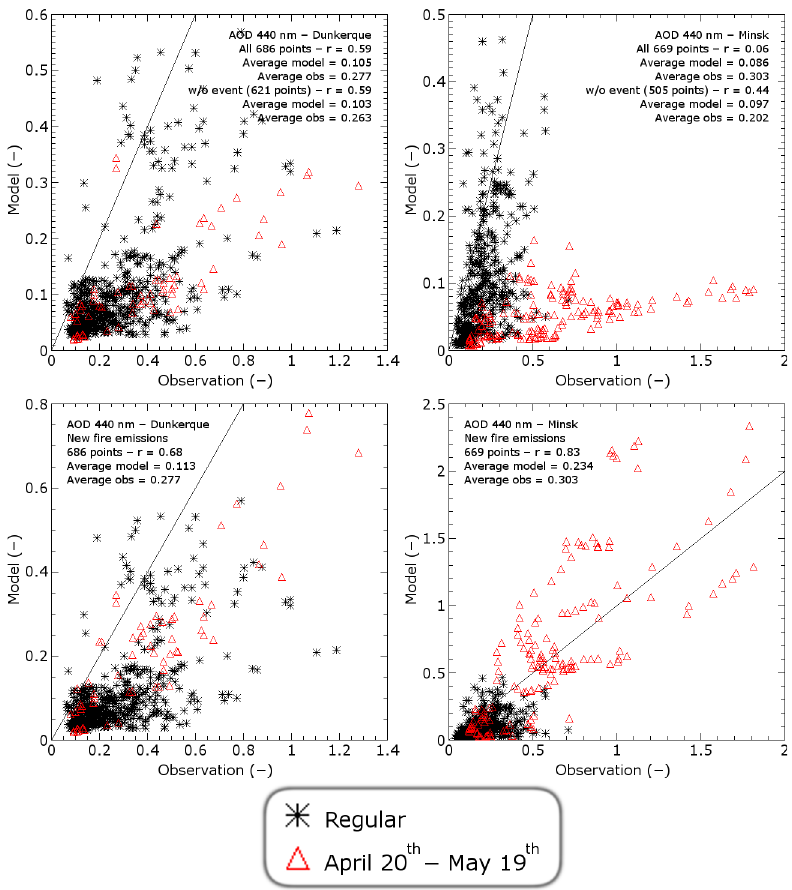
Fig. 10. Time series of modelled and observed AOD (440nm) for Dunkerque (left) and Minsk (right). Upper panels: Only climatologic GFED emissions. Lower panels: New simulation with FAS-SILAM emissions. Both simulations use the regular wet-deposition